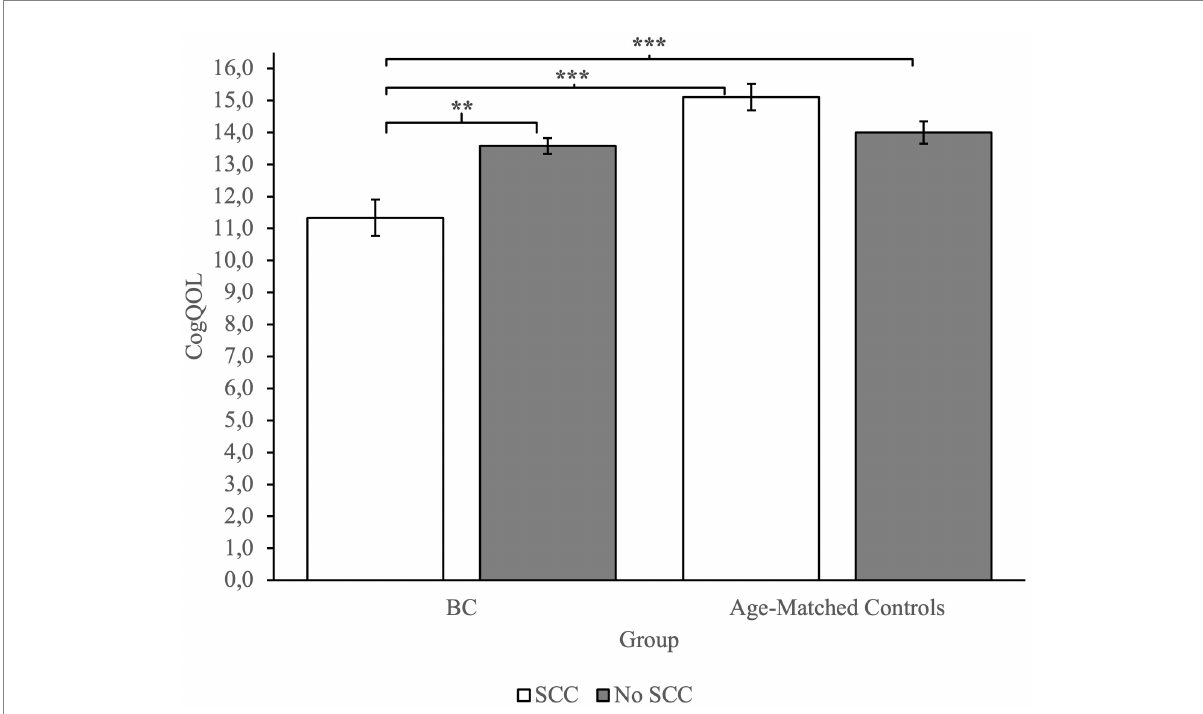
FIGURE 3 Group comparison between FACTCog Impact of perceived cognitive impairments on quality of life (QOL) measures: BC patients reporting SCC describe a significative impact of cognitive difficulties on perceived quality of life. ** p < 0.01; *** p < 0.001.